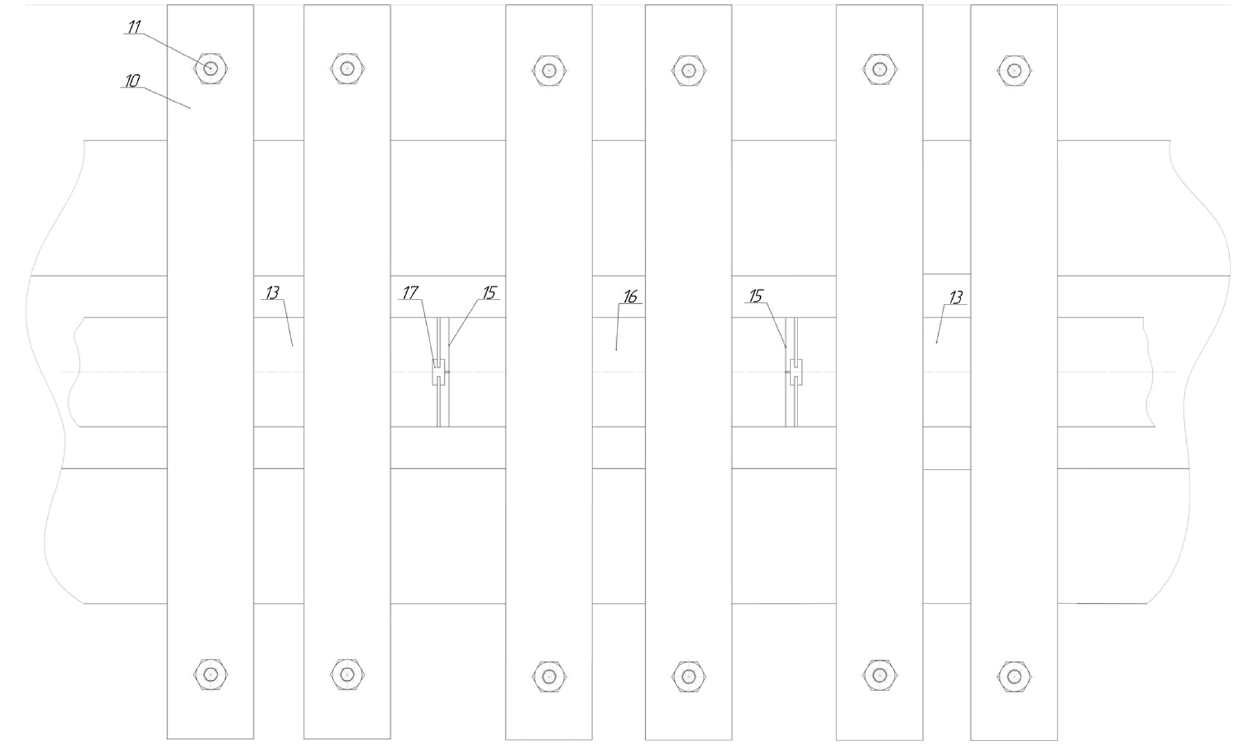
Figure 5. Top view of the device in the process of centering the pipeline after cutting out the defective section: 10—platform; 11—hexagon; 13—pipeline; 15—cutting place; 16—cut out section of the pipeline; 17—pipeline cutting machine.